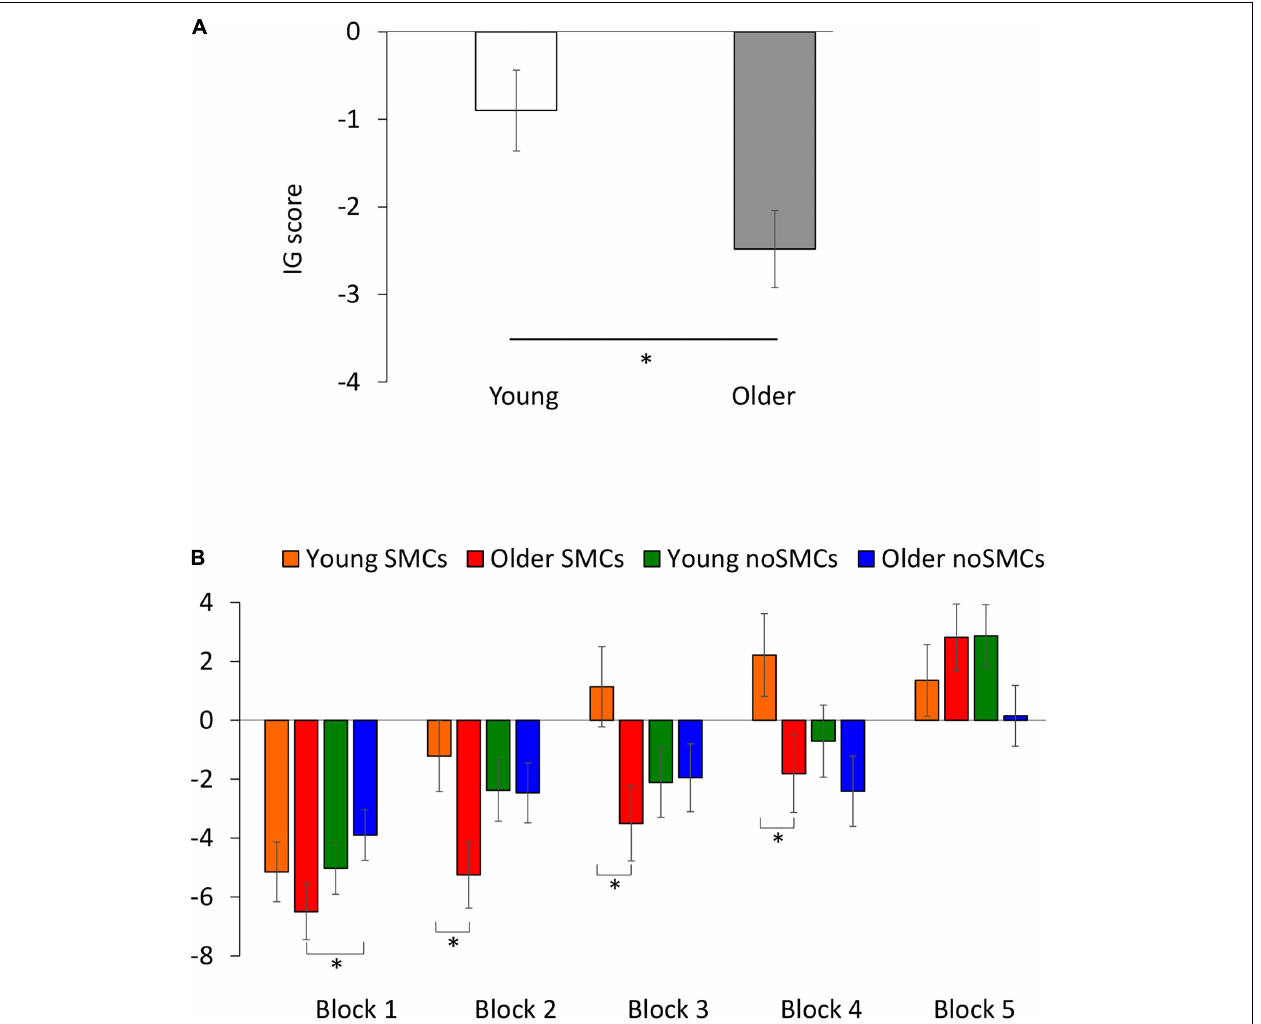
FIGURE 2 | Behavioral performance on the IGT. (A) IG index for young and older adults after 100 trials. (B) IG index for the interaction between Block, subjective memory complaints (SMCs), and Age. Means ( ± SEM) are shown. * p < 0.05.